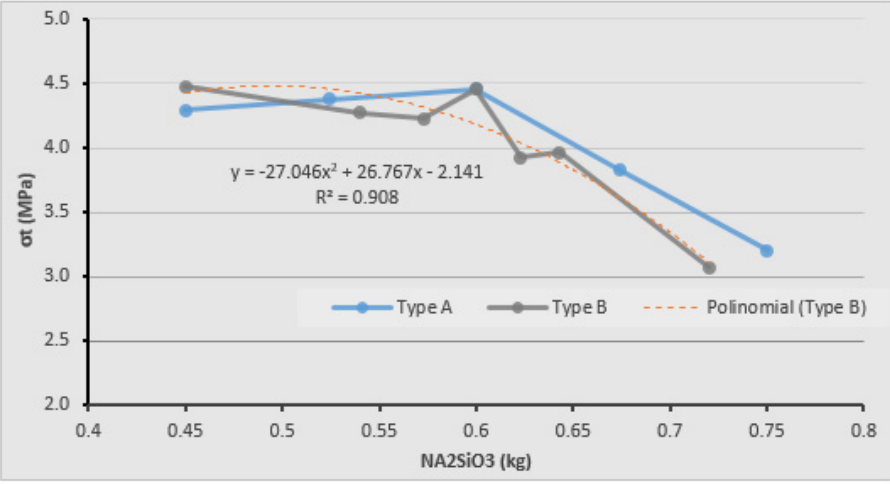
Figure 8. Influence of sodium silicate (Na2SiO3) on the tensile strength.